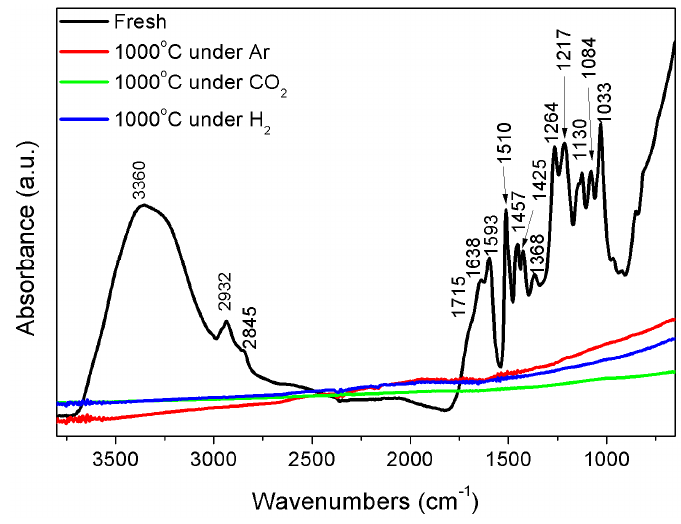
Figure 1. FTIR spectrum of raw and thermally decomposed kraft lignin.